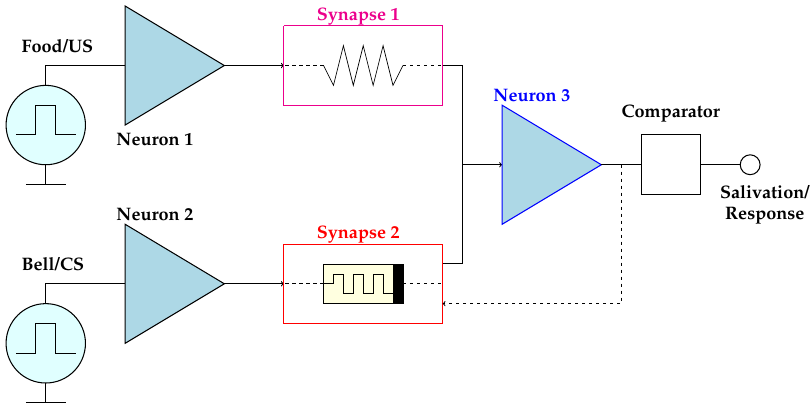
Figure 3. Block diagram of the system used to mimic Pavlovian learning